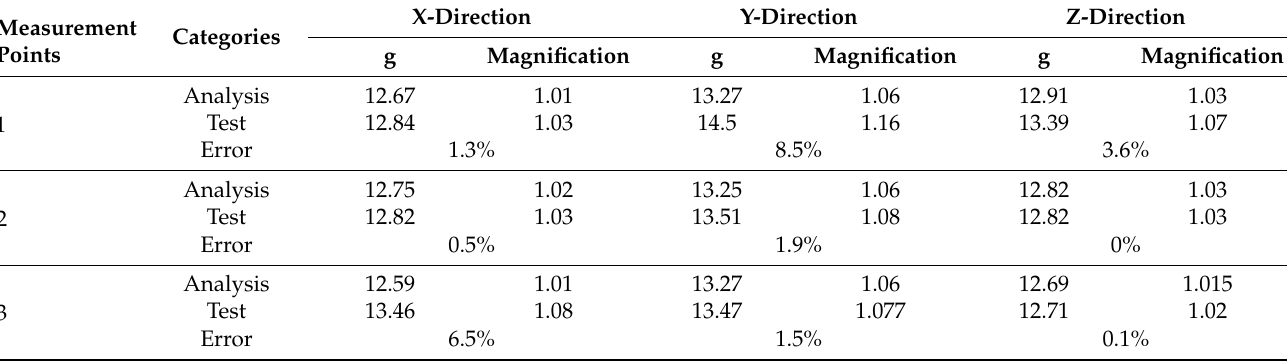
Table 7. Comparison of theoretical analysis and experimental test acceleration response